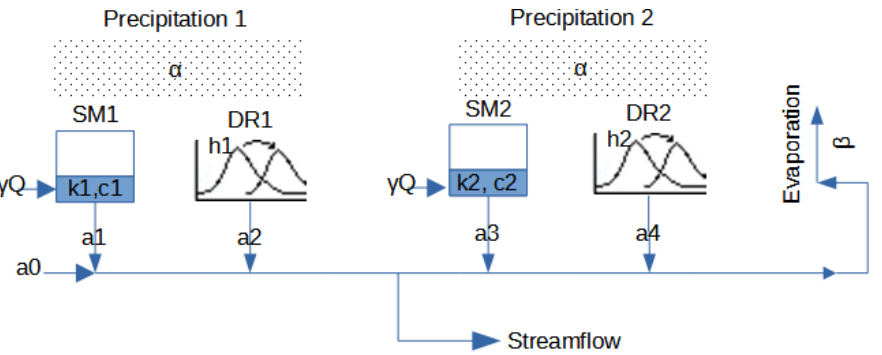
Figure 2. Schematic representation of the LRHM